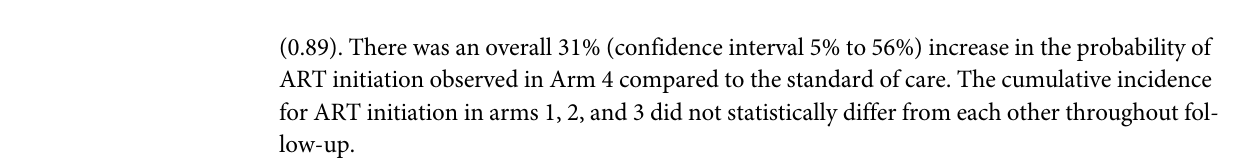
Fig 1. Cumulative incidence function (CIF) for ART initiation by trial arm. Arm 1 — Standard of care; Arm 2- Structural-level stigma intervention; Arm 3 — Individual-level intervention; Arm 4 — Both structural and individual level intervention.